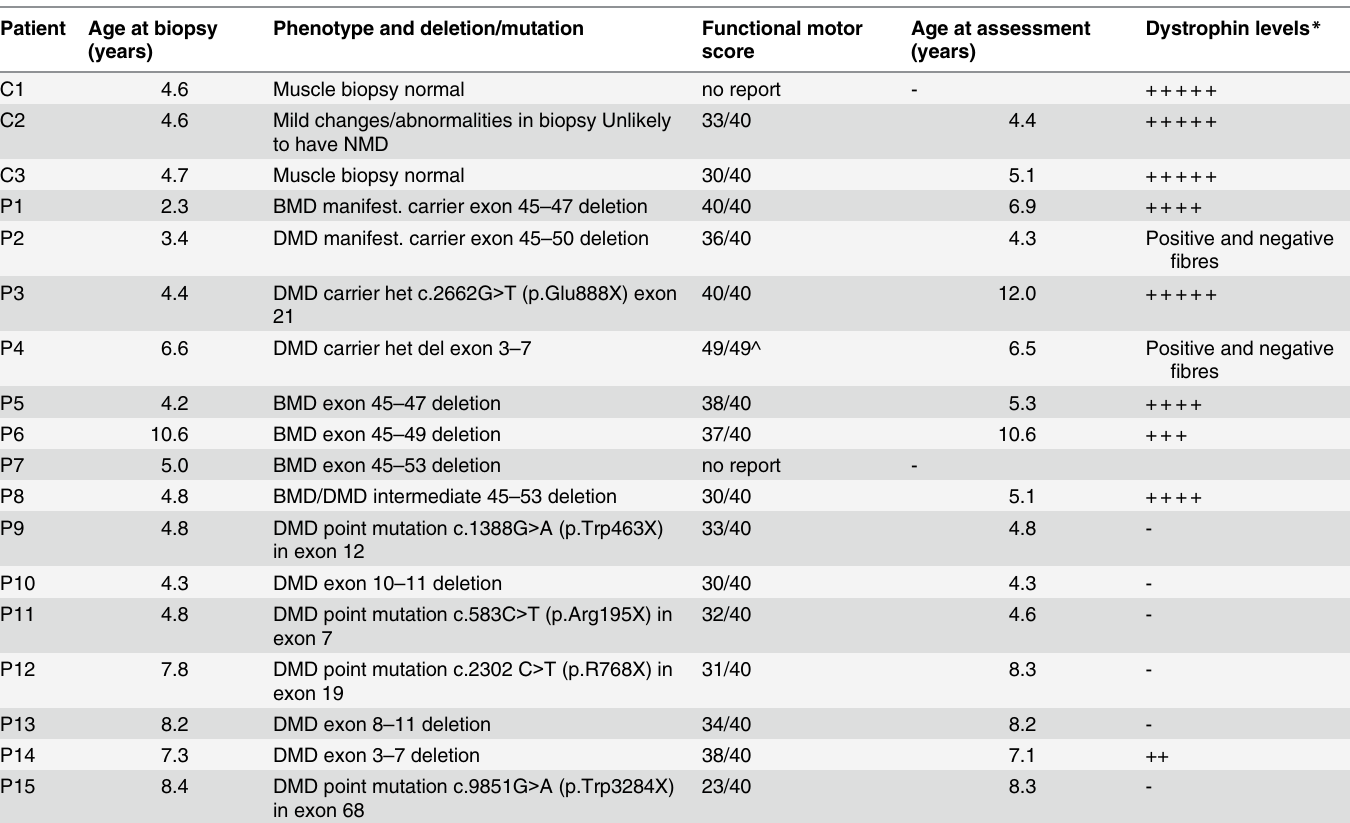
Table 1. Muscle biopsies used in study.